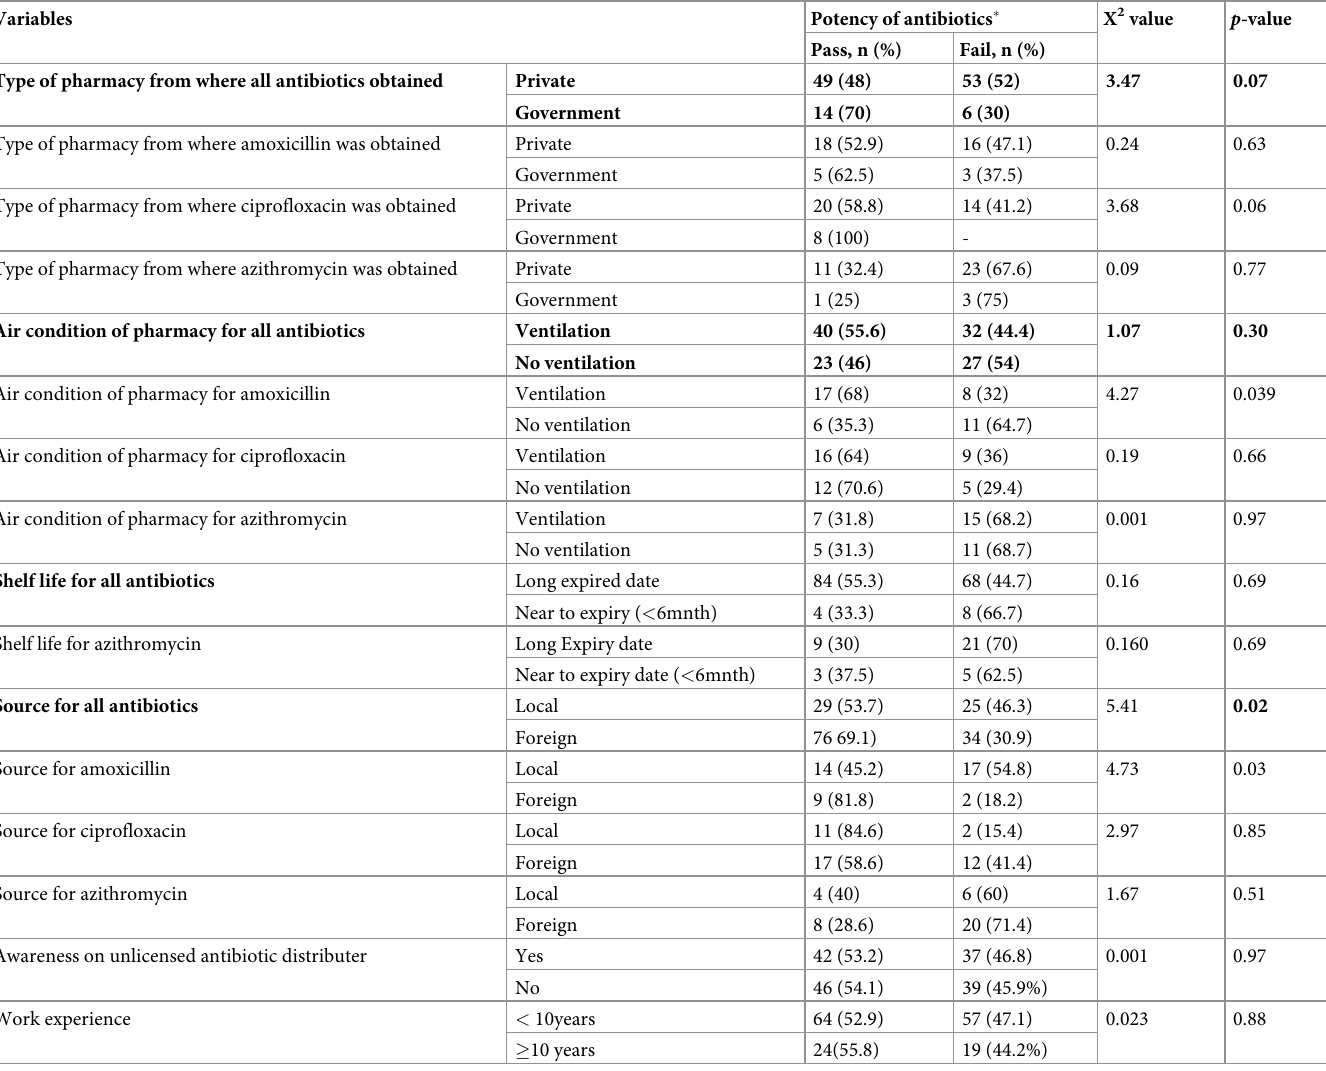
Table 6. Factors that affect the potency of selected antibiotics collected from pharmacies found in Adama, Ethiopia (March 2018 to June 2018).